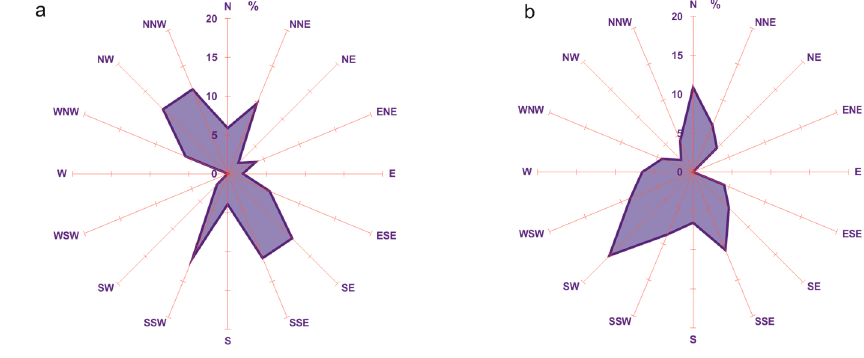
Figure 6. Spatial arrangement of northern pike embryos in an SMF of 1 mT ( a ) and a GMF ( b ) after 51 D°; the Reyleigh test [59].